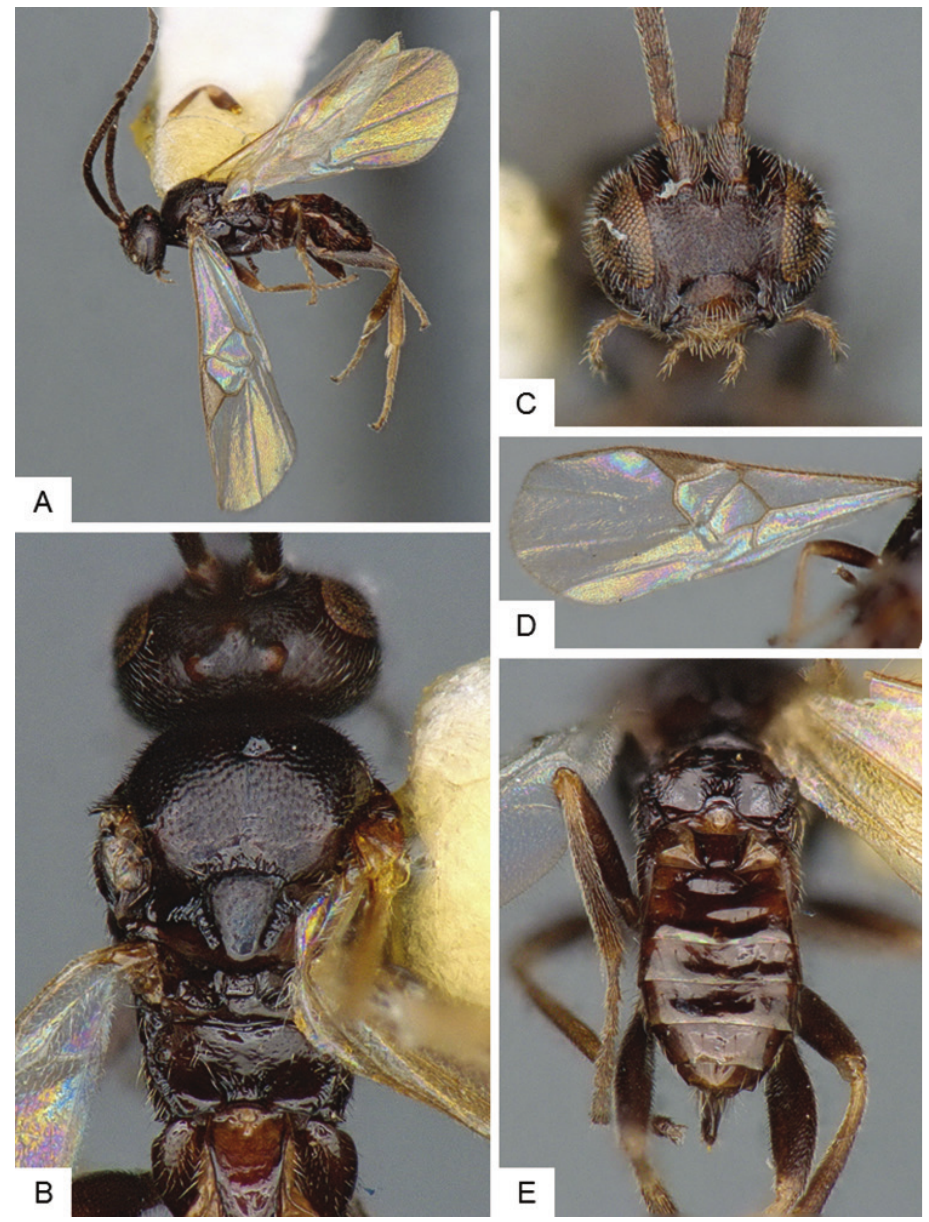
Figure 15. Glyptapanteles sp. 2. A Habitus, lateral B Head and mesosoma, dorsal C Head, fontal D Fore wing E Metasoma,